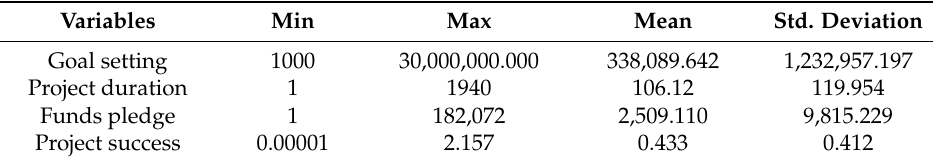
Table 1. Summarizes the descriptive statistics for each variables.